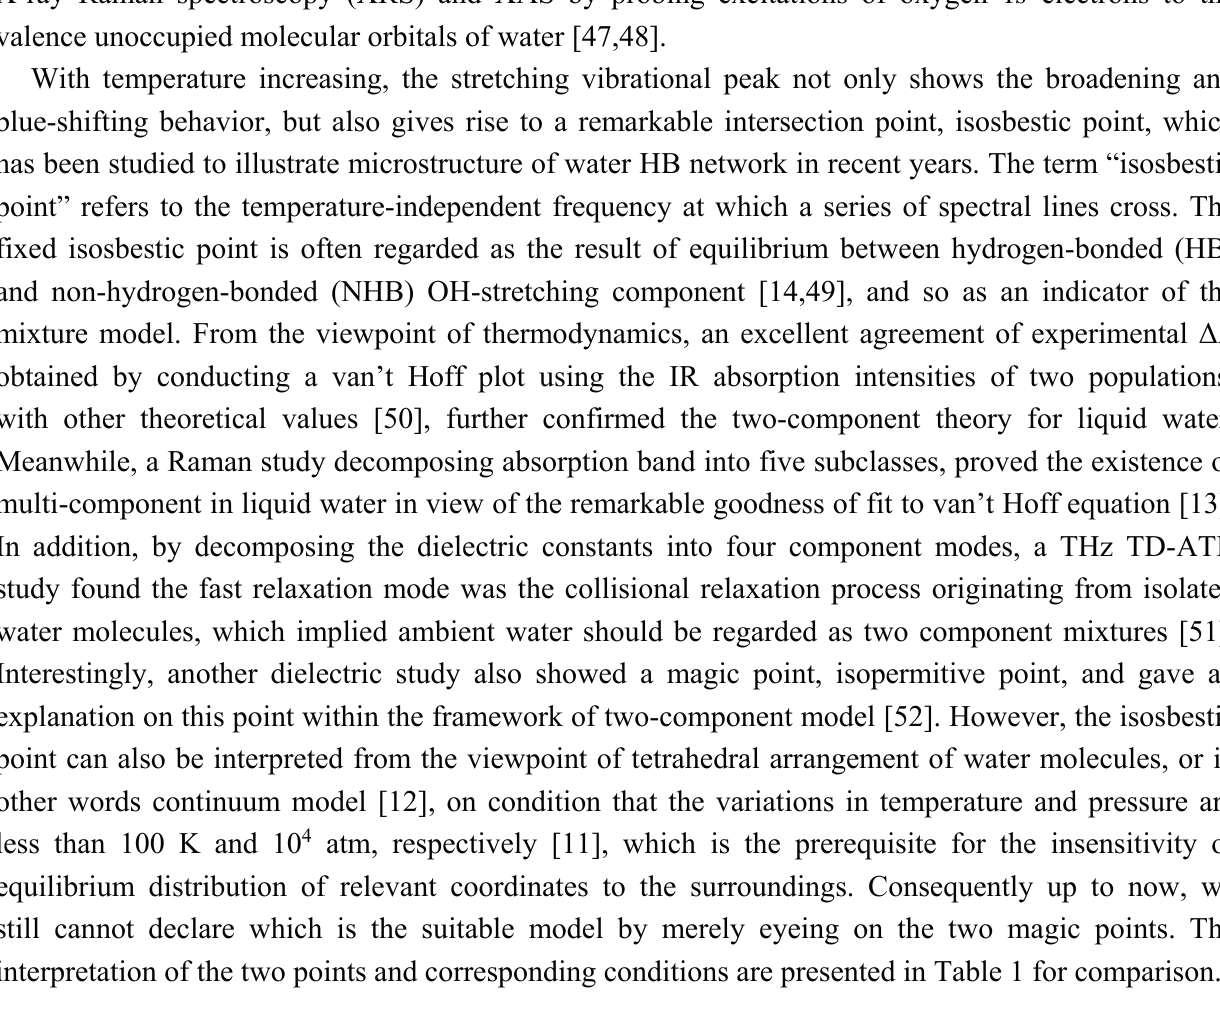
Table 1. Interpretation of isosbestic and isopermitive point for liquid